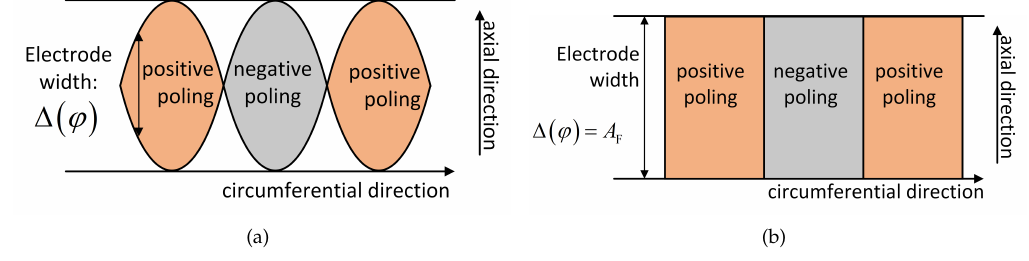
Figure 18. Distributed function ∆ ( ϕ ) : ( a ) sinusoidal function; ( b ) piecewise function.